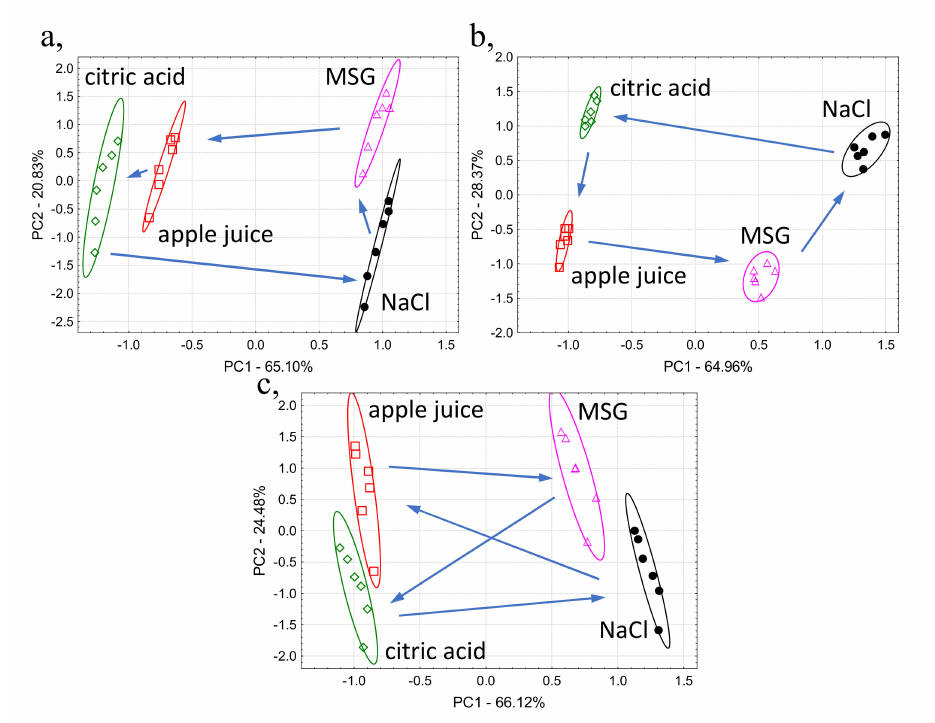
Figure 4. Principle component analysis score plots of the electronic tongue results of apple juice and model solution samples measured in three di ff erent sample orders: ( a ) citric acid NaCl, MSG, apple juice and: ( b ) reverse sample order: citric acid, apple juice, MSG, NaCl and: ( c ) citric acid, NaCl, apple juice,